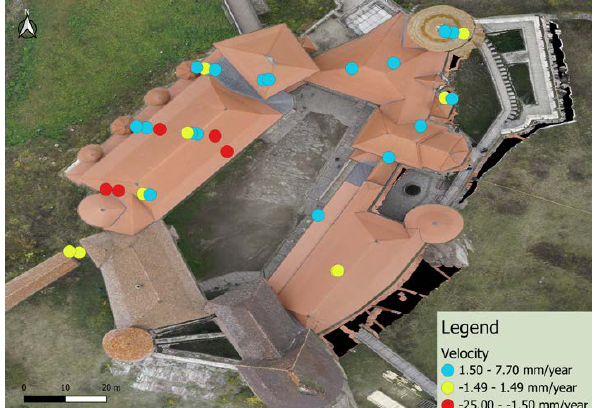
Figure 1. Monitoring displacements of the Corvin Castel using PSinSAR